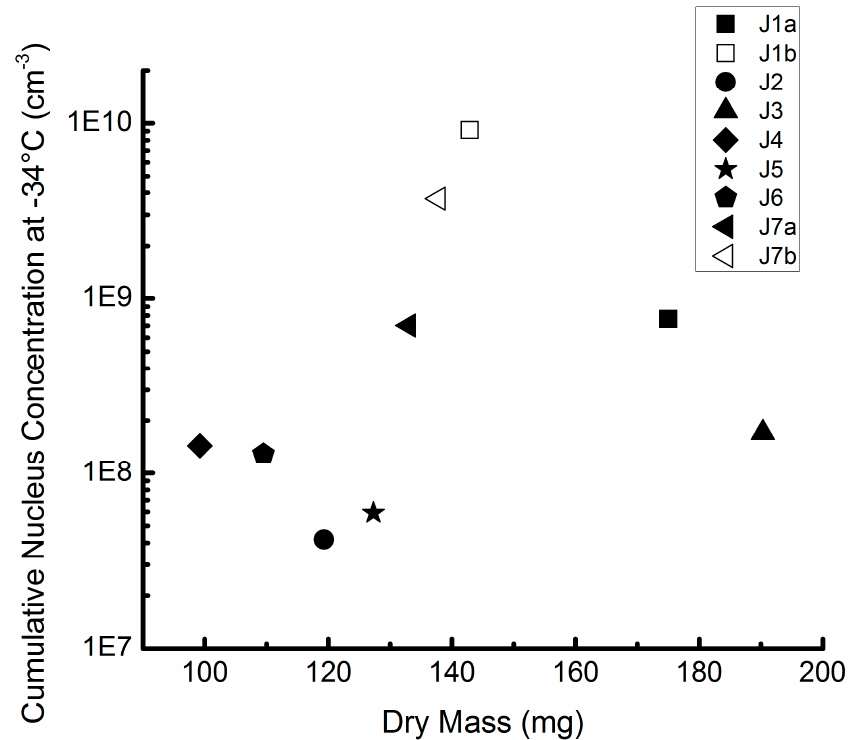
Figure 4. Relationship between the INP concentration of the juice samples and their dry mass. Included juices were black currant (J1a,b), blueberry (J2), chokeberry (J3), cranberry (J4), lingonberry (J5), sambuccus (J6), sea buckthorn (J7a,b). Linear regression (not shown) yields an R 2 value of 0.0124.